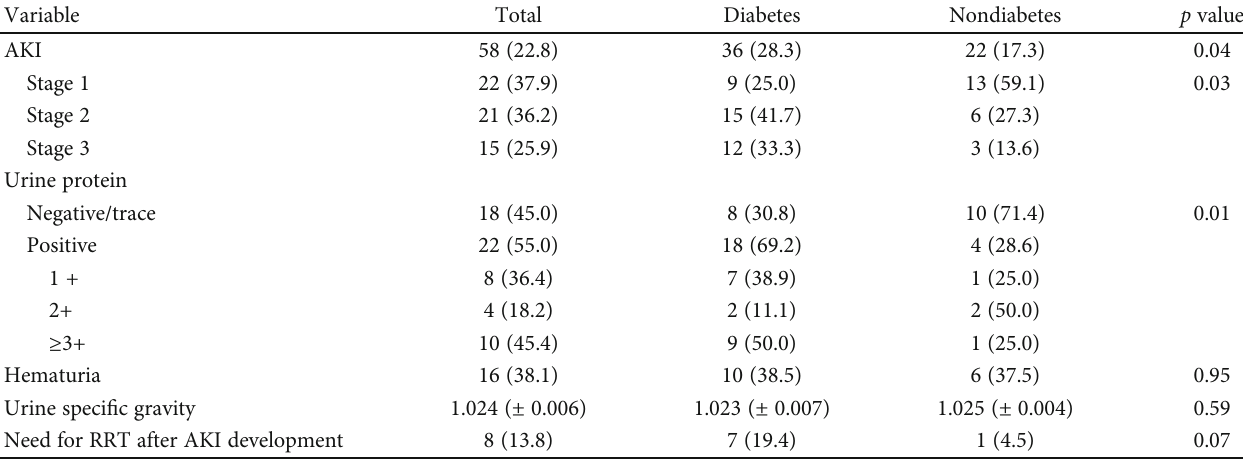
Table 3: Kidney involvement among study subjects, by diabetes status.